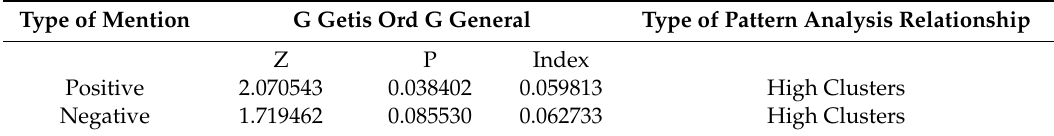
Table 11. G Getis Ord test on Room